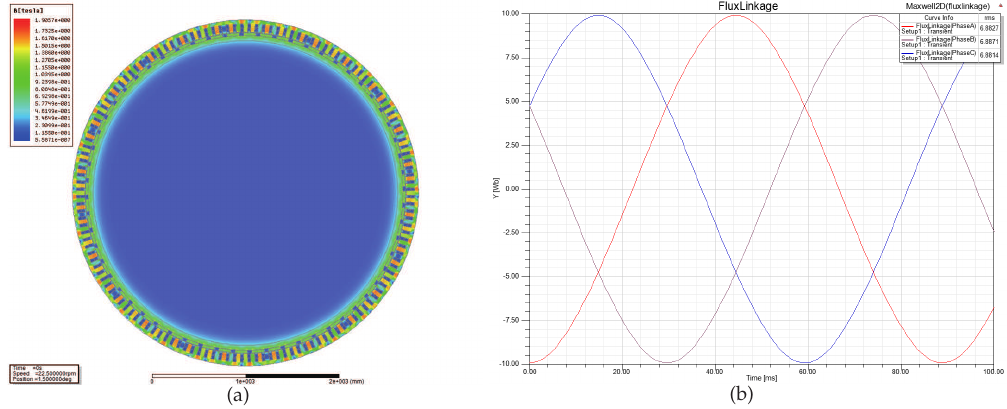
Figure 12. Results of finite element analysis with ψ f ≈ 6.88 Wb in Case 4 : ( a ) Nephogram of magnetic flux density; ( b ) Corresponding waveform of magnetic flux